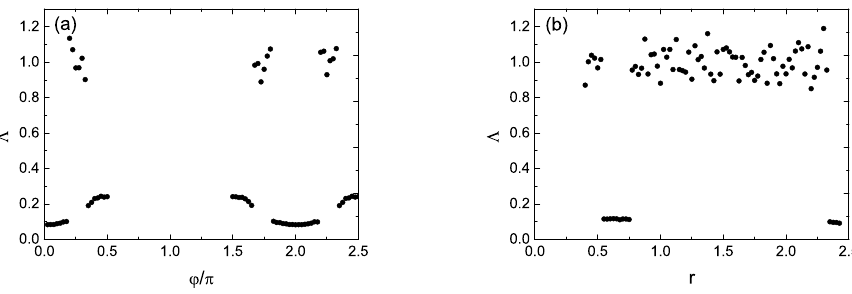
Figure 11. Same as Figure 10 but the dependence of the 0–1 test chaos indicator Λ on the initial value ϕ or r . The regular and chaotic properties described by the 0–1 test are the same as those given by the FLIs in Figure